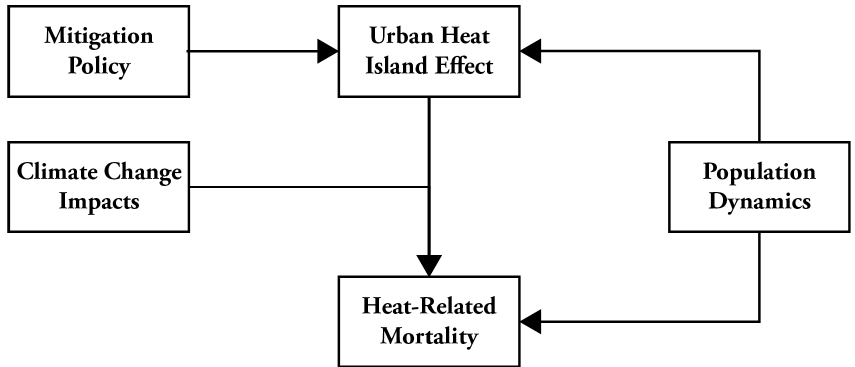
Figure 1. Generalized Relationships between UHIMPT Model Components.